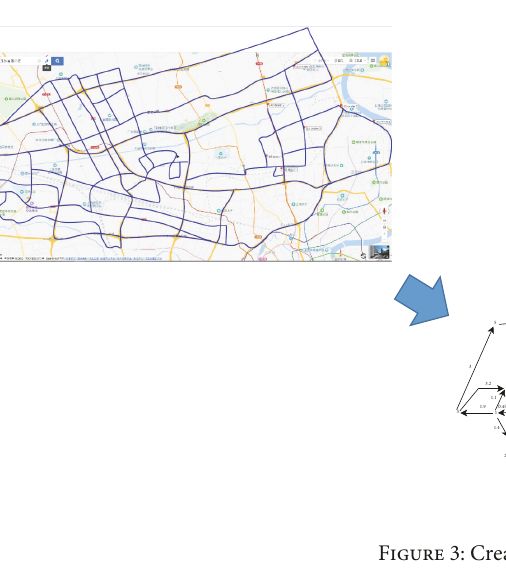
The algorithm is coded with Matlab2013 on a computer with 2.3GHZ processor and 4.0GB memory with Win- Crossover probability is set as 0.85, and mutation